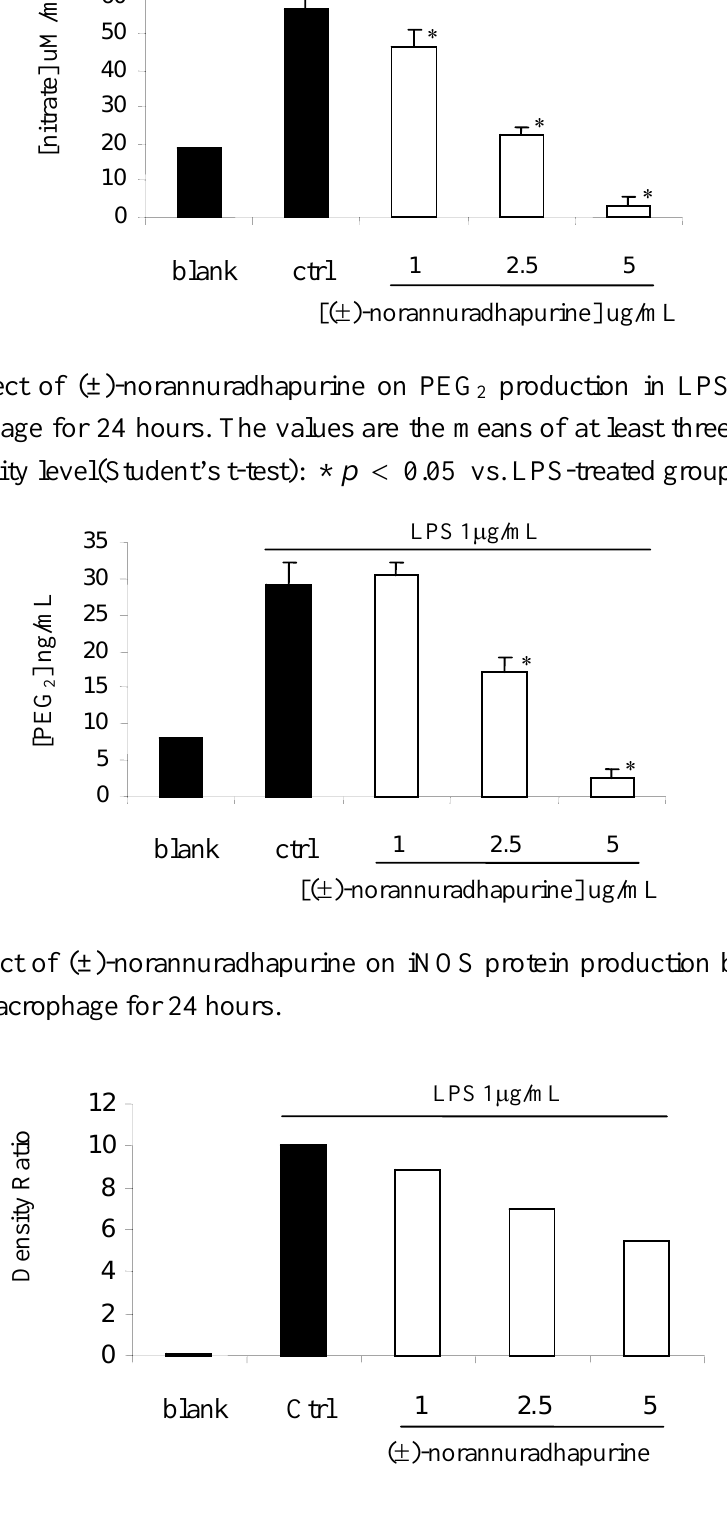
Figure 1 . Evaluation of nitrite production by RAW 264.7 cells stimulated for 24 hours with LPS alone or combination with increasing concentrations (1-5 μ g/mL) of (±)- norannuradhapurine. The values are the means of at least three determinations ± SD.